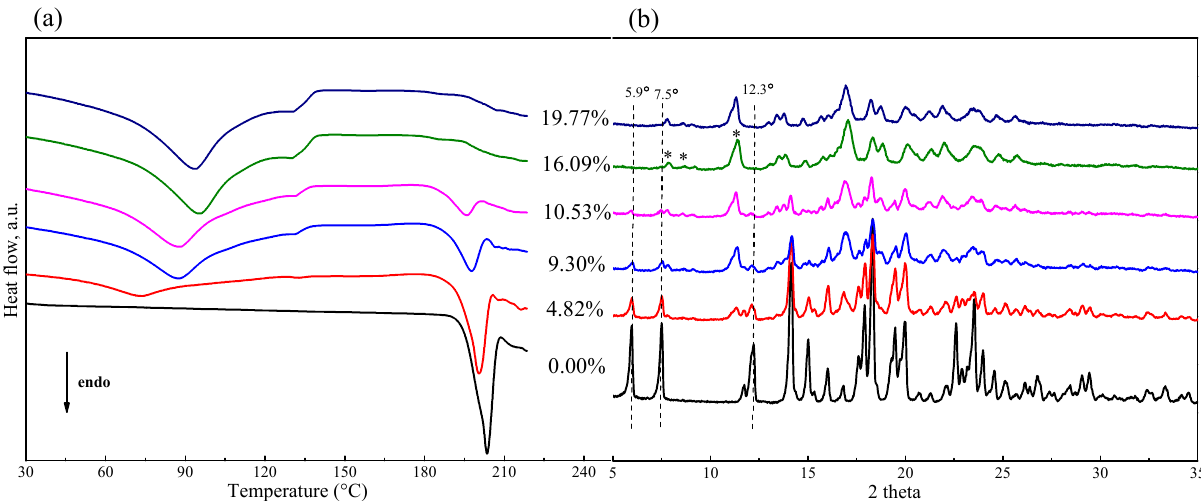
Figure 3. Powder X ‐ ray diffraction (PXRD) ( A ) and Fourier transforms infrared (FTIR) spectroscopy ( B ) of the FXD solid forms.